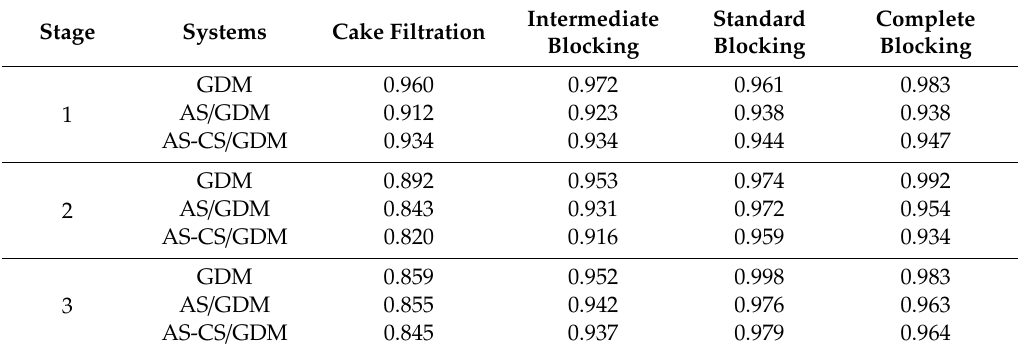
Table 1. R 2 values of regression analyses of membrane fouling during the di ff erent systems by four